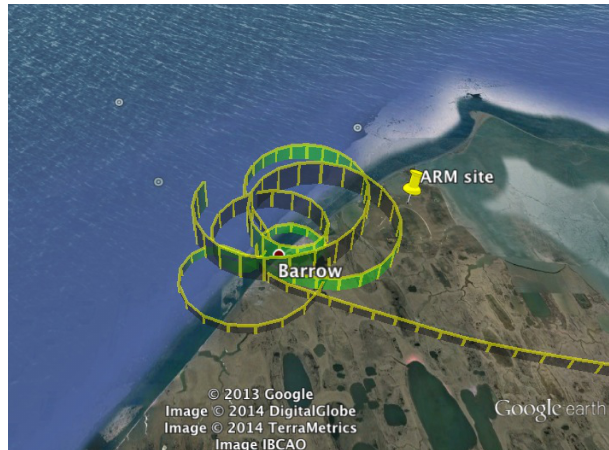
Figure 3. Flight track for UND Citation on 9 October 21:46– 22:07UTC during M-PACE campaign. ARM ground-measurement site marked with the yellow